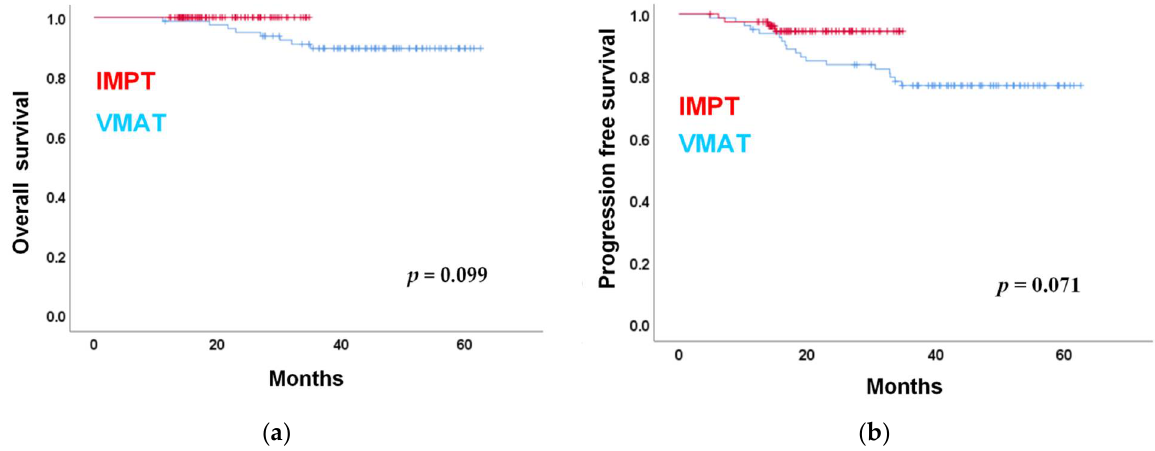
Figure 1. ( a ) Overall survival; ( b ) progression-free survival. Kaplan–Meier analysis of the IMPT and VMAT patients. Abbreviations: IMPT: Intensity-modulated proton therapy, VMAT: Volumetric modulated arc therapy. Table 2. Univariate and multivariate analysis for progression-free survival.